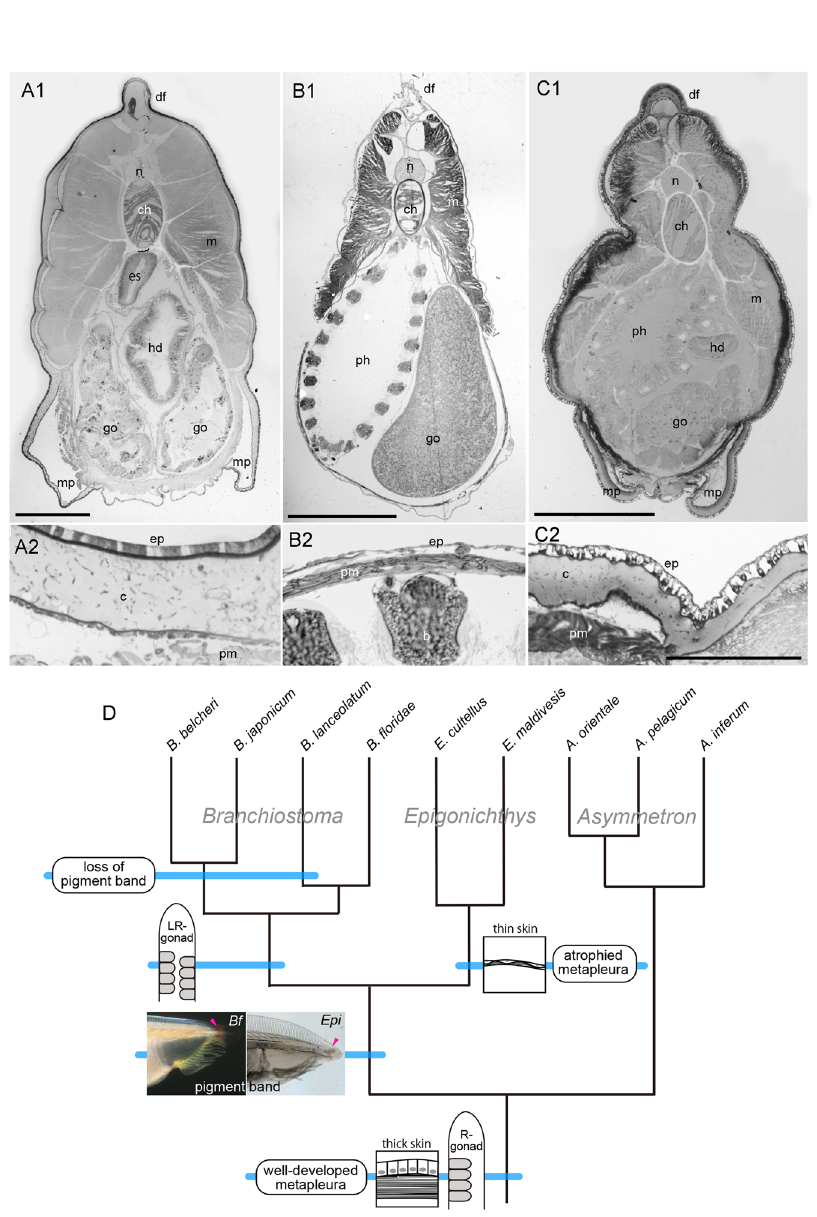
Figure 6. Transverse sections of three amphioxus genera and parsimoniously expected character polarity. ( A1 ) Transverse section at posterior pharyngeal region of Branchiostoma japonicum . ( A2 ) Thick epidermal epithelium and collagen layer in B. japonicum . ( B1 ) Transverse section at pharyngeal region of Epigonichthys maldivensis . ( B2 ) Squamosal epidermal epithelium and very thin collagen layer in E. maldivensis . ( C1 ) Transverse section at posterior pharyngeal region of Asymmetron pelagicum . ( C2 ) Cuboidal epidermal epithelium and well-developed collagen layer. ( D ) Metapleura, thick skin, and dextral gonads are ancestral characters in amphioxus lineage. Genus Epigonichthys displays most derived features. Branching pattern in Branchiostoma clade follows nucleotide-based trees. b, branchial bar; Bf , Branchiostoma floridae ; c, collagen layer; ch, notochord; df, dorsal fin; ep, epidermis; Epi , Epigonichthys ; es, esophagus; go, gonad; hd, hepatic diverticulum; m, myomeric muscle; mp, metapleuron; ph, pharynx; pm, pterygial muscle. Scale bars 0.5 mm for A1, B1, C1, and 0.2 mm for C2 applicable to A2,